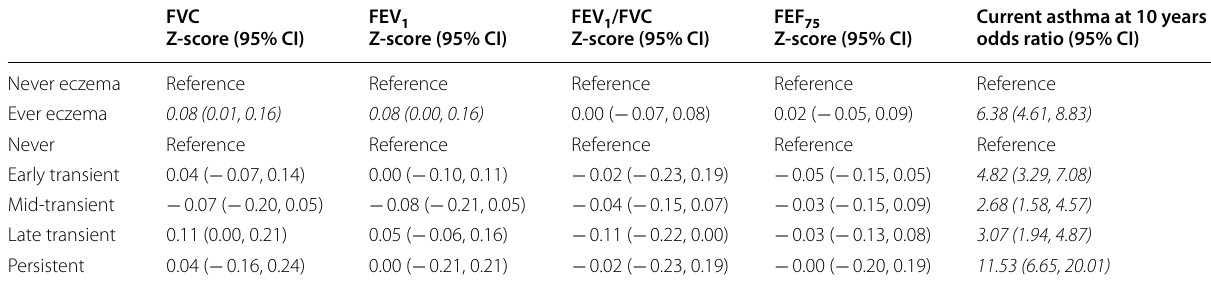
Values are Z-score mean differences for lung function measurements and odds ratios (95% confidence intervals) for current asthma from linear and logistic regression models for never/ever eczema. Values are average Z-score mean differences for lung function measurements and average odds ratios (95% confidence intervals) for current asthma from linear and logistic regression models, respectively, after multiple sampling based on 150 imputed datasets for eczema phenotypes. Lung function outcomes are force expiratory volume in 1 second (FEV 1 ), forced vital capacity (FVC), force expiratory flow at 75% of the exhaled FVC (FEF 75 ). Full models were adjusted for parental history of allergy, asthma or eczema, maternal education, parity, child’s sex, ethnicity and breastfeeding. Italic values indicate statistical significance at the α 0.05 =